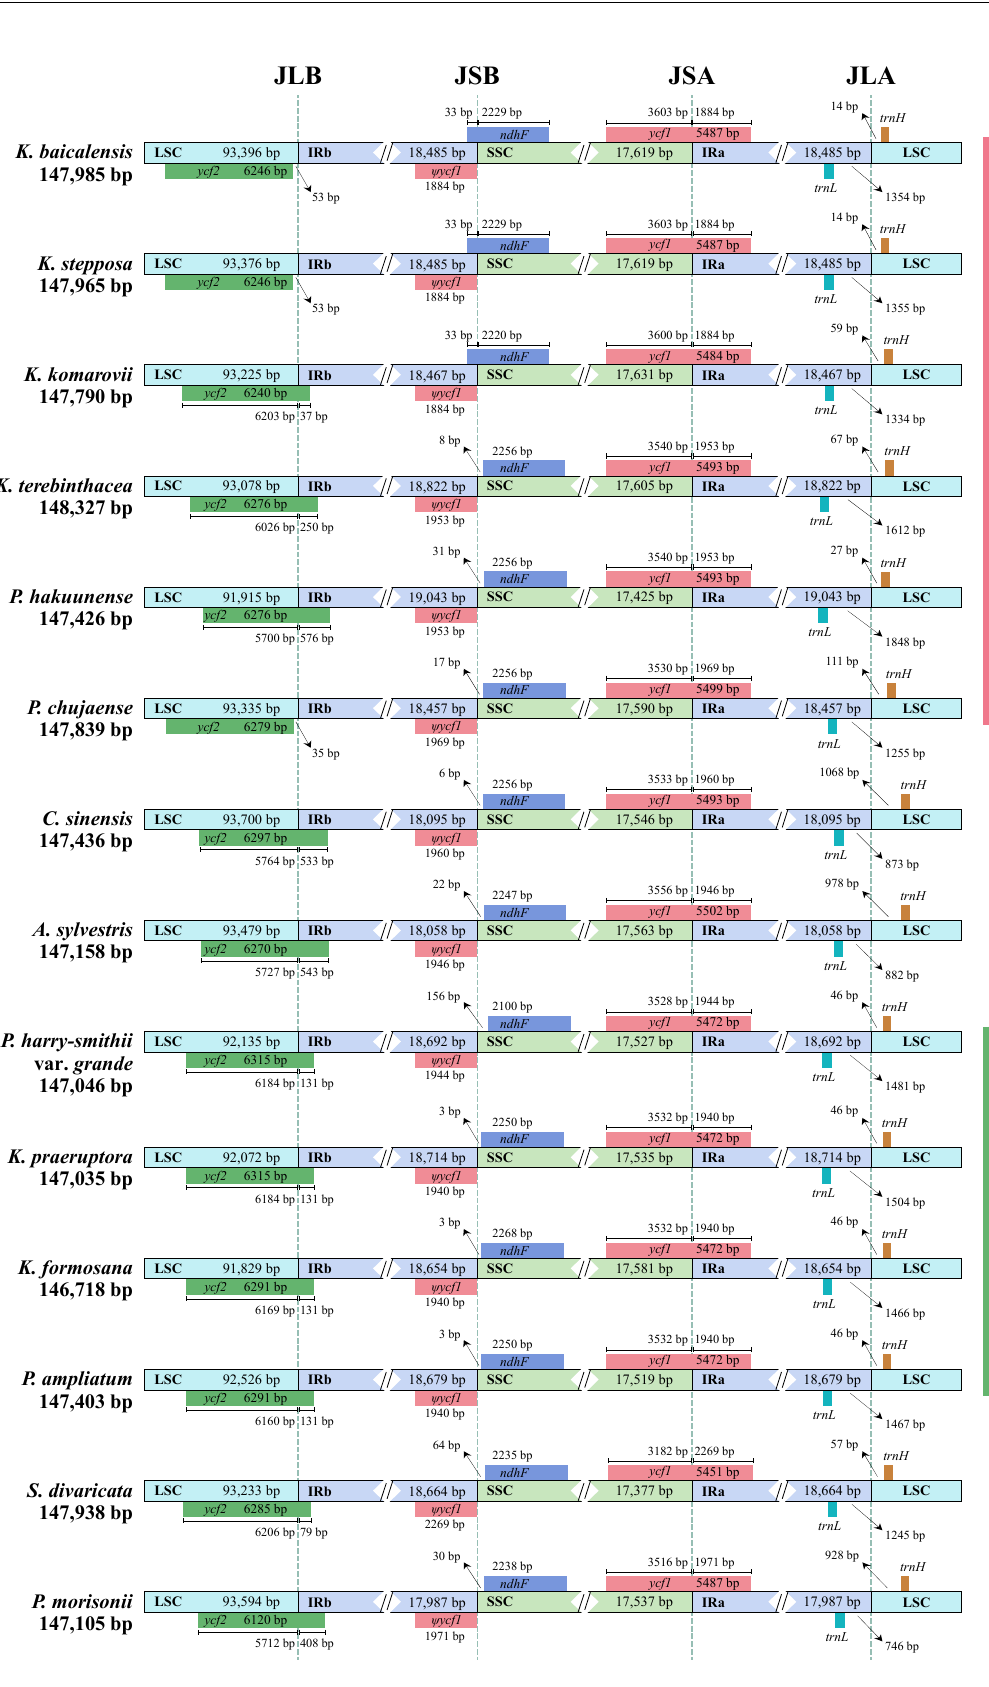
Figure 3. Comparison of the border regions of the 14 plastomes of Kitagawia and related taxa. Different boxes for genes represent the gene